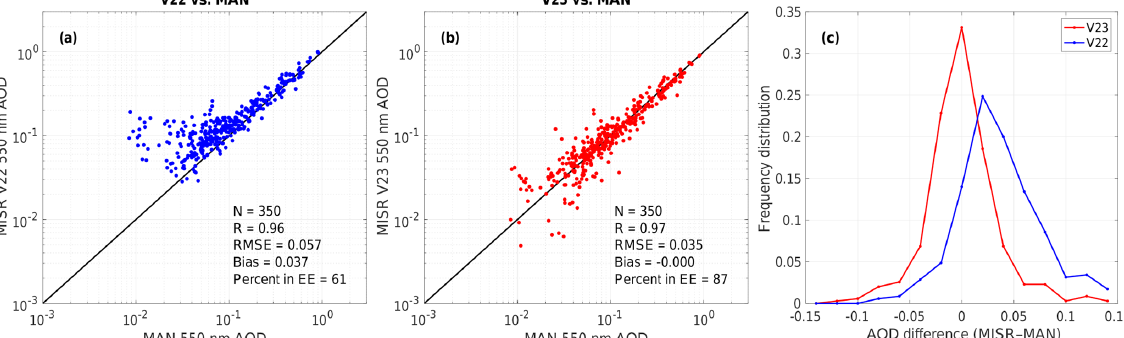
Figure 16. Scatterplots and statistical comparison between collocated MISR V22, MISR V23, and MAN observations: (a) scatterplot of MISR V22–MAN collocations including overall statistics, (b) scatterplot of MISR V23–MAN collocations including overall statistics, and (c) histograms of the MISR–MAN AOD difference for V23 (red) and V22 (blue)